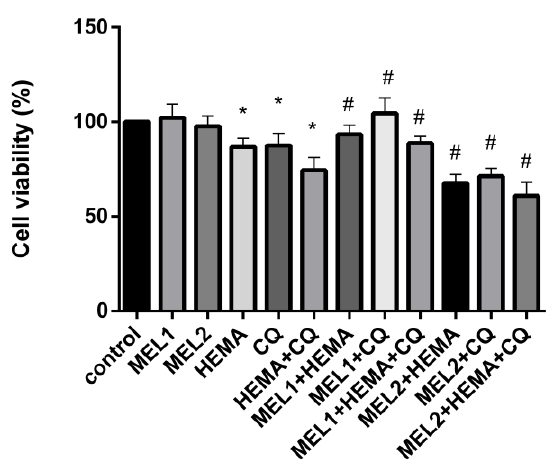
Figure 2. Human dental pulp cells viability (%) after treatment with HEMA and/or CQ in the presence of melatonin (24 h) assessed by MTT assay. Each graph bar represents the mean ± SD of four experiments. * p < 0.05 chemical vs. control; # p < 0.05 chemical with melatonin vs. without melatonin. HEMA—2-hydroxyethyl methacrylate (5 mM); CQ—camphorquinone (1 mM); and MEL1 (0.1 mM) and MEL2 (1 mM) — melatonin.